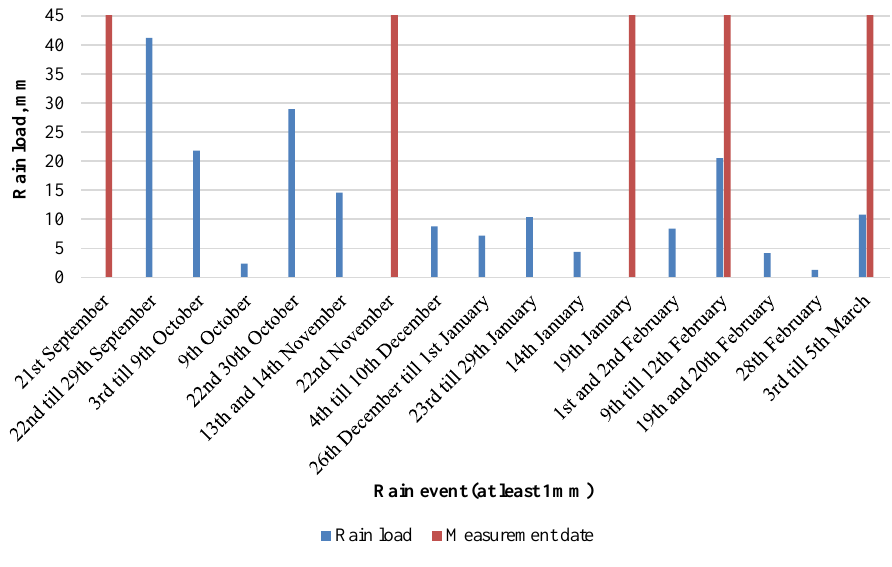
Fig. 9. Rain load event during the monitoring period.